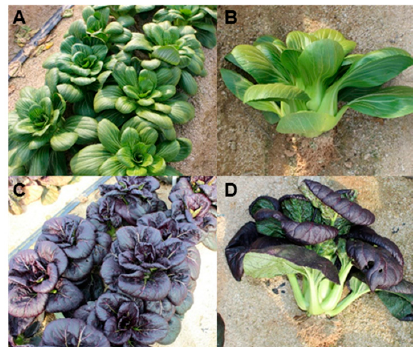
Figure 1. Photographs of mature pakchoi. Green pakchoi cultivar ‘8210’ ( A , B ) and purple pakchoi cultivar ‘8389’ ( C , D ).